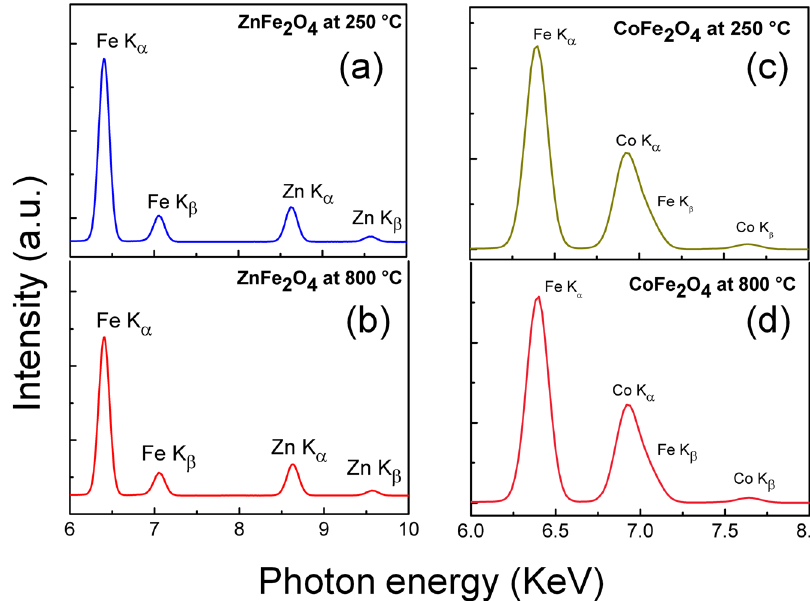
Fig. 2 XRF spectra for the a , b ZnFe 2 O 4 and c , d CoFe 2 O 4 NPs calcined at 250 °C and 800